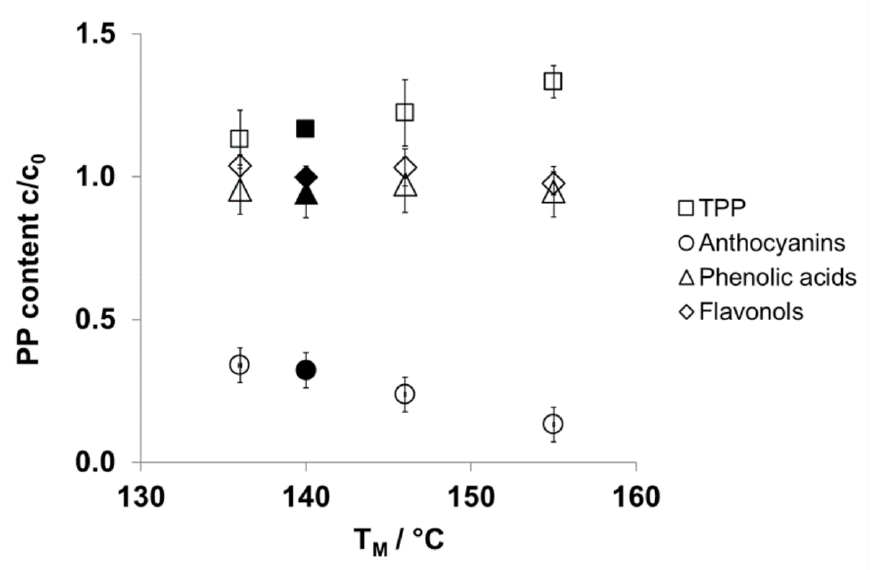
Figure 4. Thermomechanical impact on polyphenol (PP) stability in chokeberry pomace powder (CPP) after extrusion processing (mean ± SD, n = 2). c 0 , based on CPP; T M , material temperature.